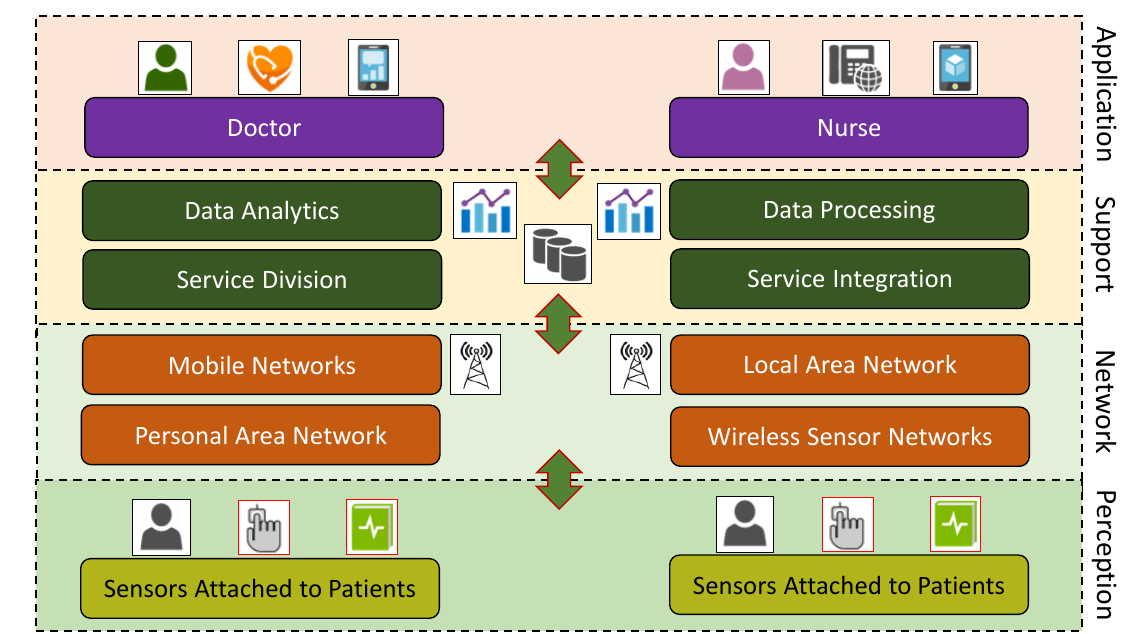
Figure 4. An illustration of a smart healthcare application scenario used in our